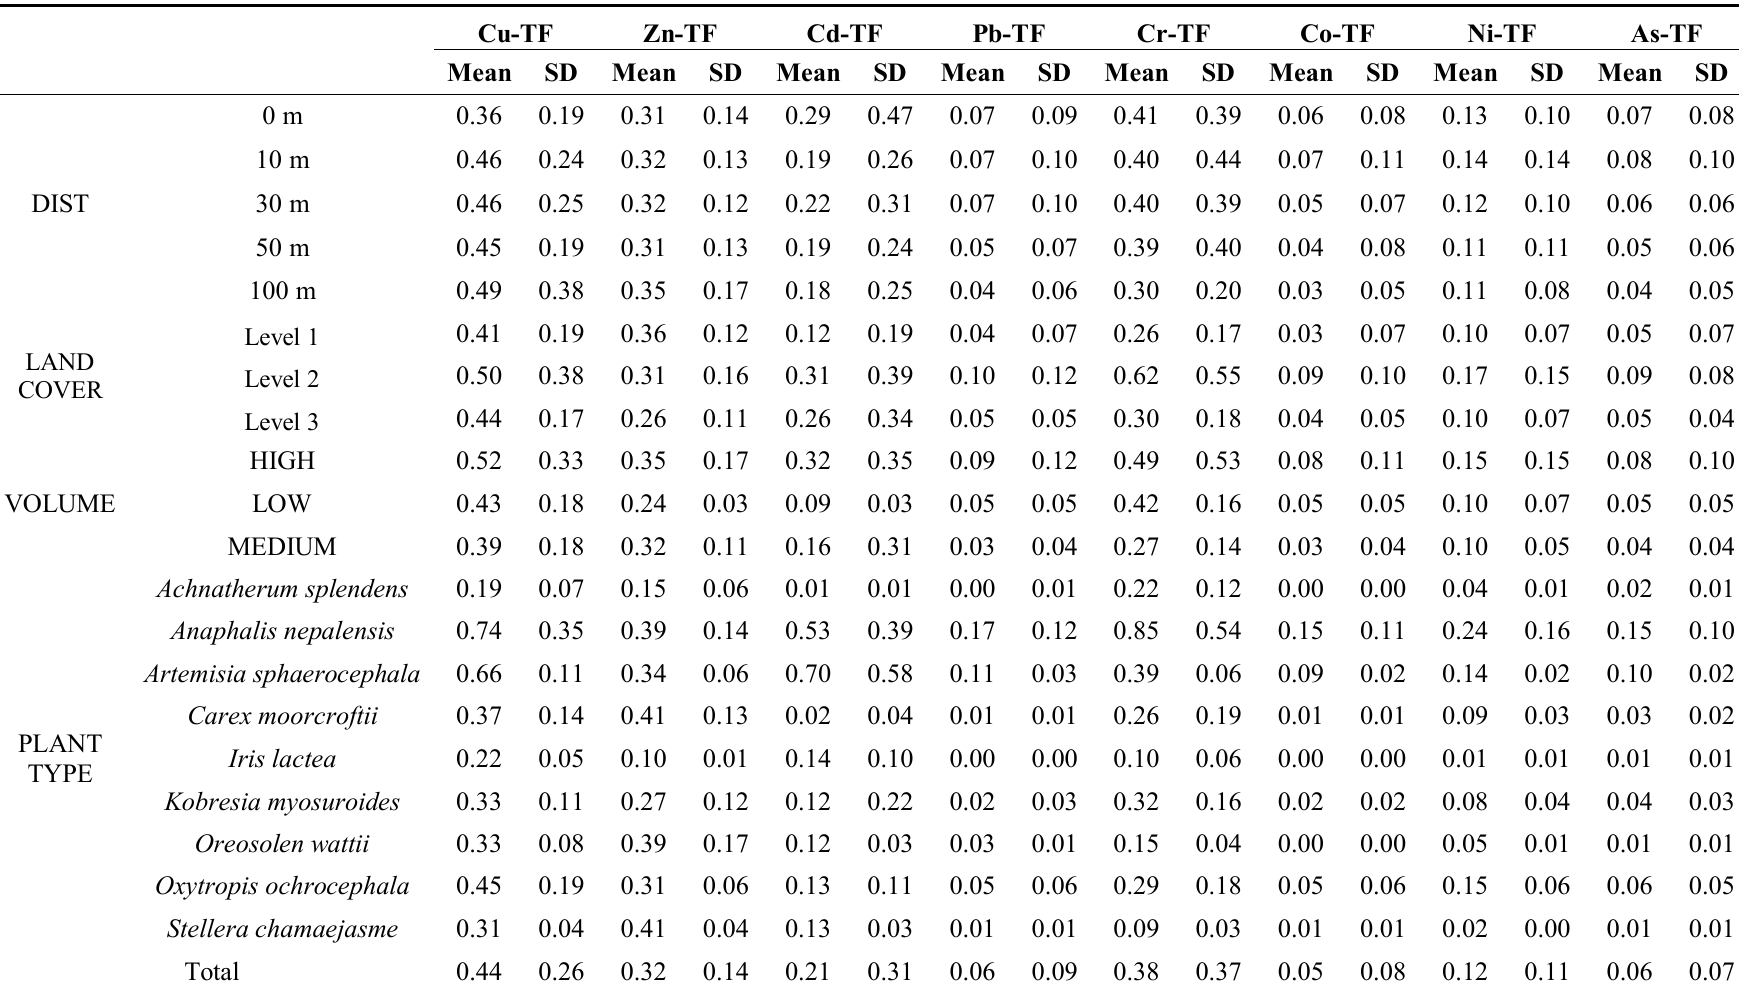
Table 10. Descriptive statistical results of Transfer Factor (TF) of grass-soil trace element concentrations.